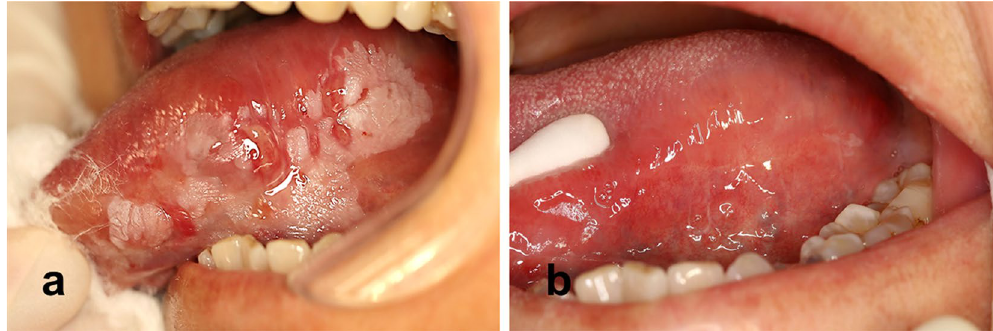
Figure 1. Preoperative ( a ) and postoperative ( b ) treatment of OL patients. The patient’s oral lesions were recorded by taking pictures.